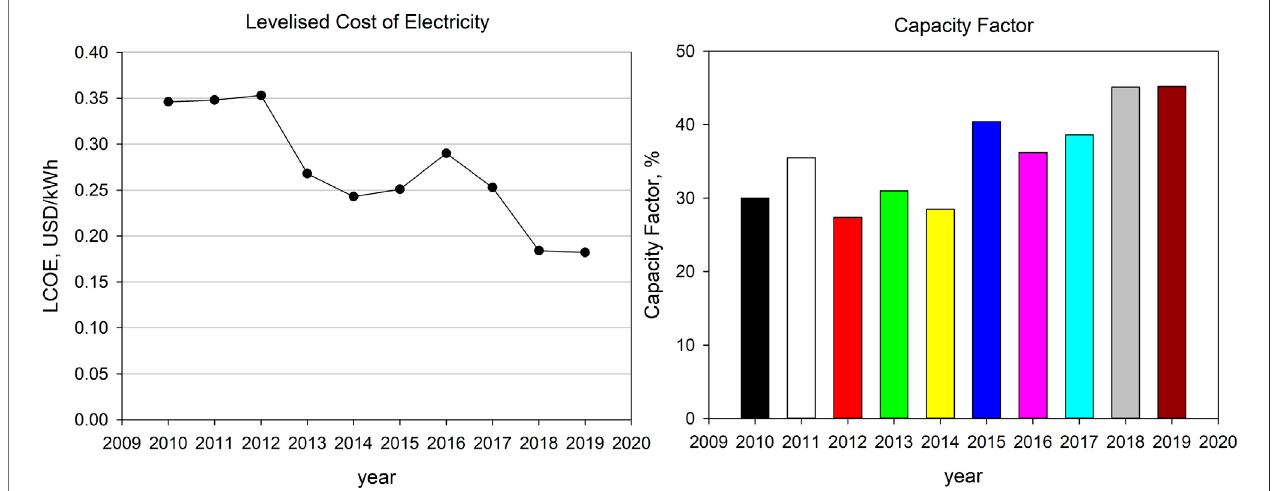
FIGURE 1 | Global weighted total LCOE and capacity factor for CSP (adapted from IRENA Renewable Cost Database (© IRENA (2020)).